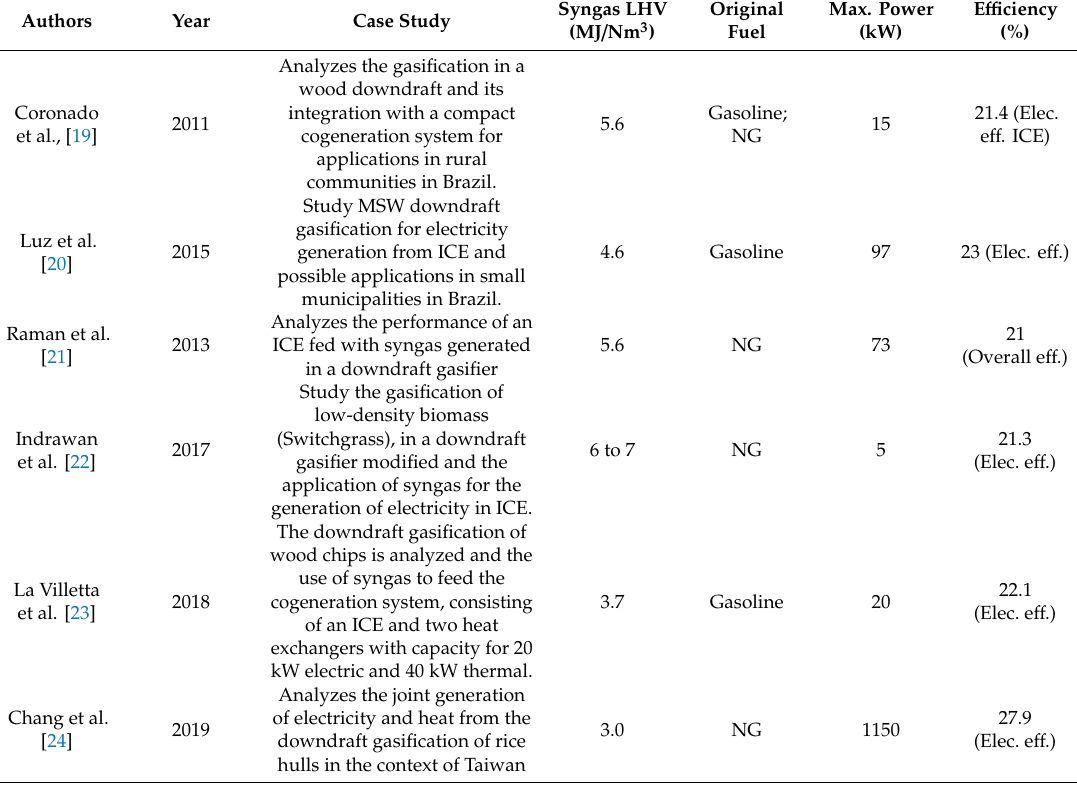
Table 1. Various experimental studies on electricity generation using downdraft